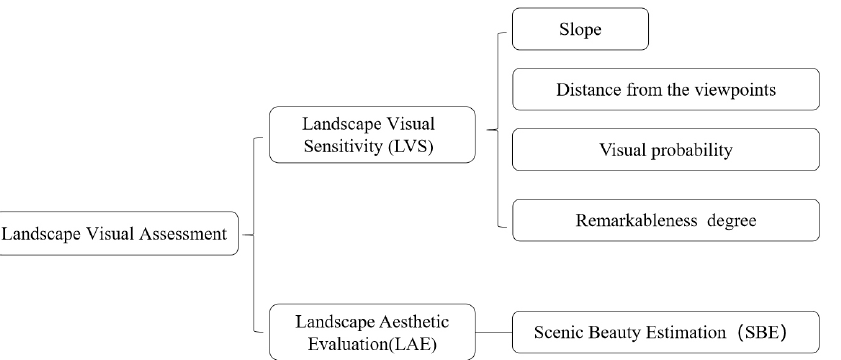
Figure 2. The framework of landscape visual assessment.